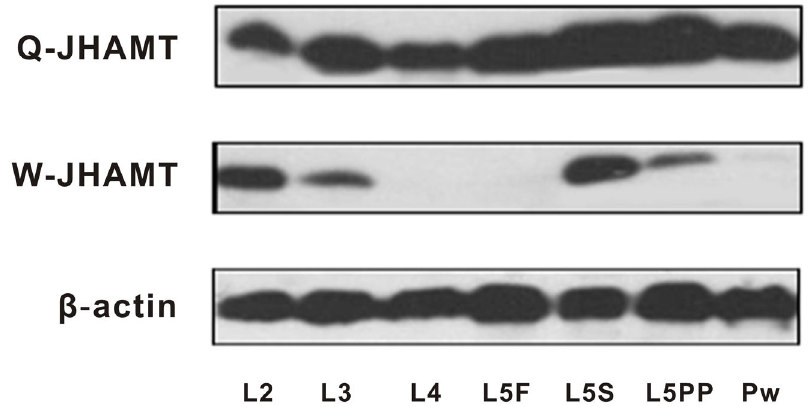
Figure 6. Immunoblotting analysis of AmJHAMT protein level during honey bee caste development. . Q- and W-JHAMT mean the AmJHAMT protein expressed in queen larvae and in worker larvae, respectively. β-actin was set as an internal reference. The abbreviations of the developmental stages are as follows: L2, the second instar; L3, the third instar; L4, the fourth instar; L5F, the feeding stage of the fifth instar; L5S, the spinning stage of the fifth instar; L5PP, the prepupal stage of the fifth instar; Pw, the white-eyed